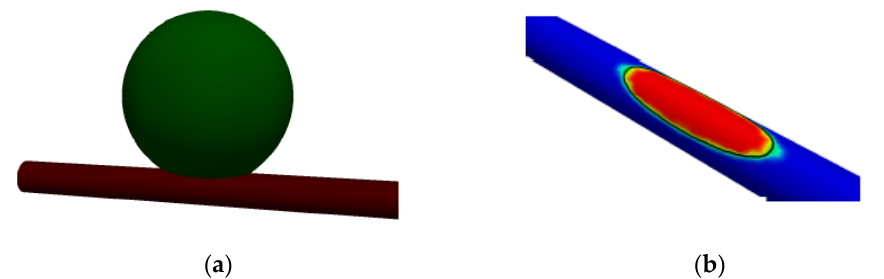
Figure 11. Wetting of a single water droplet on a hydrophobic thin fiber in diesel: ( a ) shape of the water droplet; ( b ) contact line (black) of a water droplet where red corresponds to water and blue corresponds to diesel.